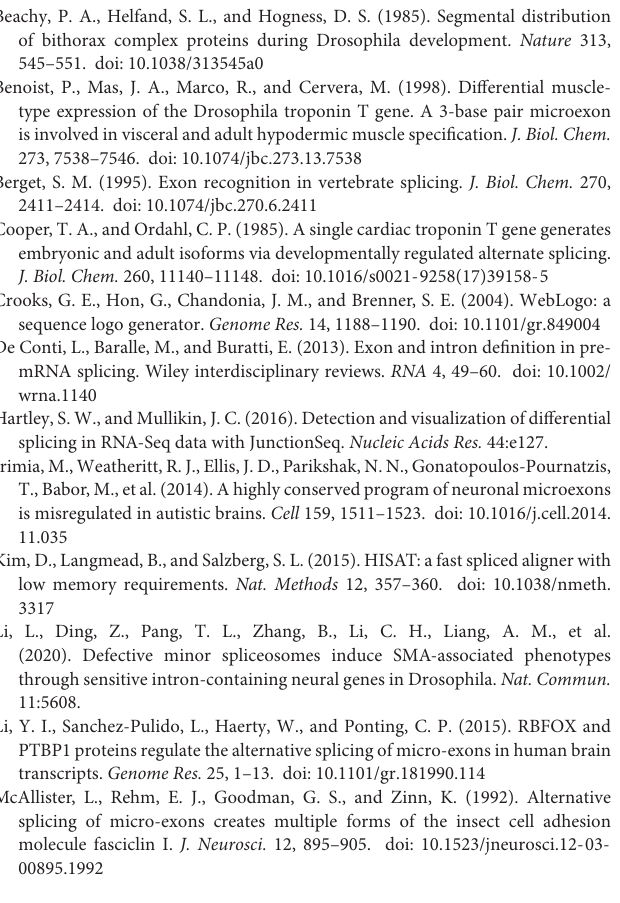
Supplementary Figure 2 | Remapping of the TopHat-unmapped reads by ce-TopHat. Supplementary Figure 3 | The top five GO enrichments of microexon-containing genes.